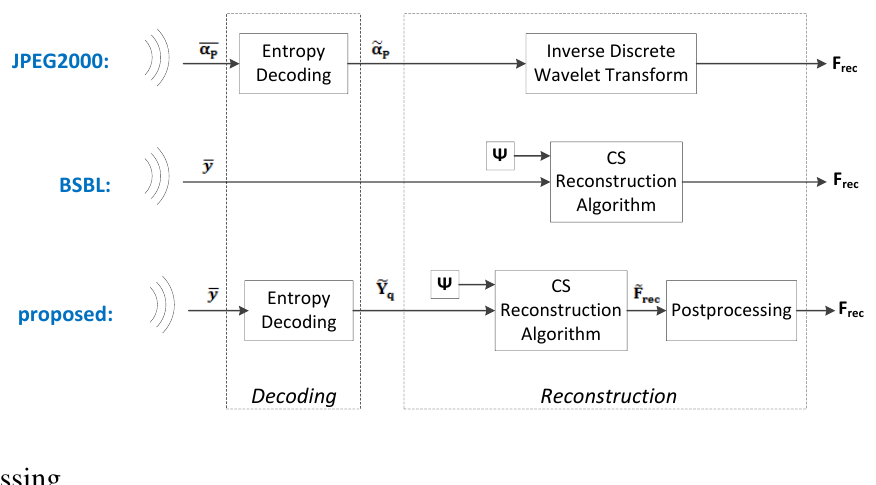
Figure 3. Block diagrams of the server node for (1) the JPEG2000-based framework ( Top ); (2) the BSBL framework ( Middle ); and (3) our CS-based framework ( Bottom